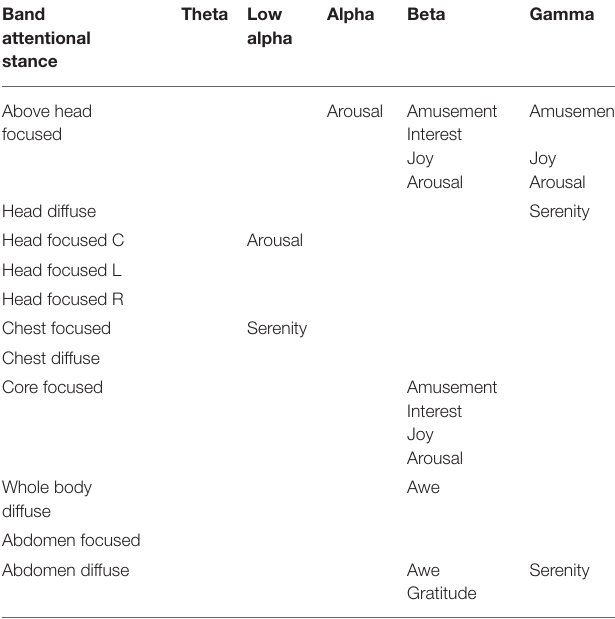
TABLE 1 | Band-specific correlations between attentional stances and positive emotions or arousal ≥ 0.5 (i.e., significant at p ≤ 0.002). Band